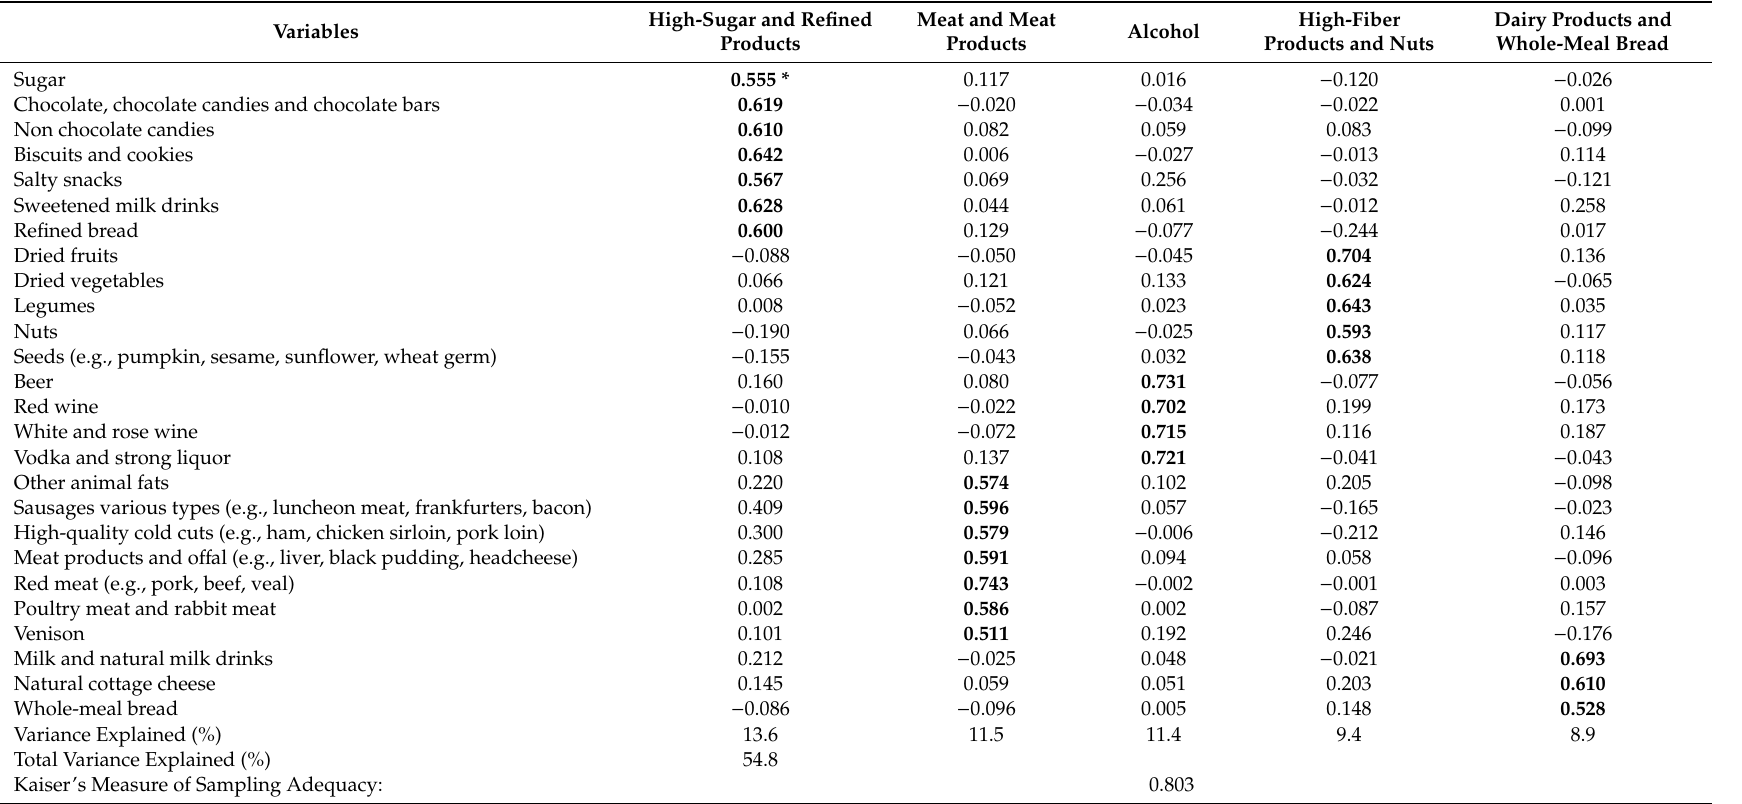
Table 1. Factor-loading matrix for the dietary patterns (DPs) identified by factor